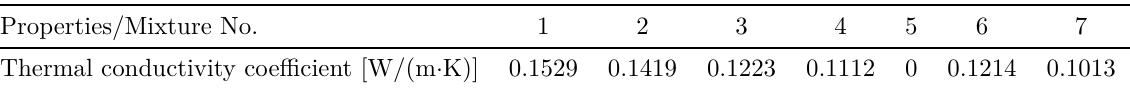
Table 4. Thermal conductivity coefficient of lightweight concrete in hardened